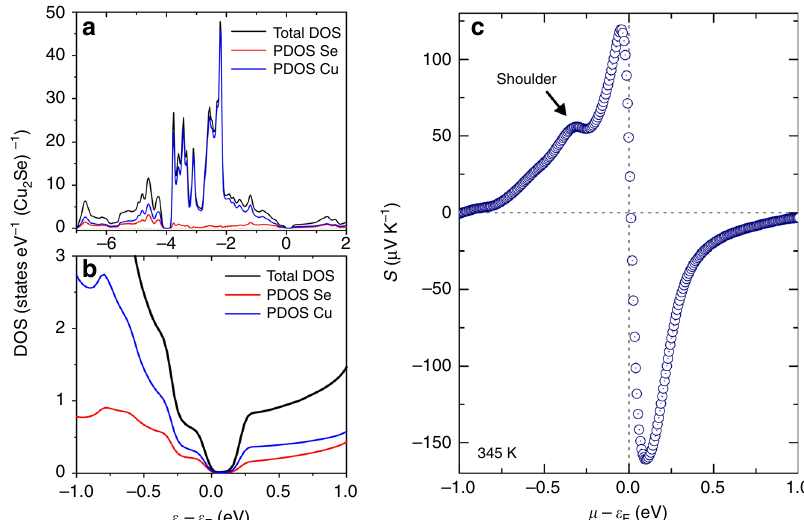
Fig. 5 Calculated electronic density of states and Seebeck coef fi cient of the simpli fi ed Cu 2 Se. a Electronic density of states calculated by Wien2k. b Zoom- in of the near gap region. c The calculated Seebeck coef fi cient as a function of chemical potential at 345